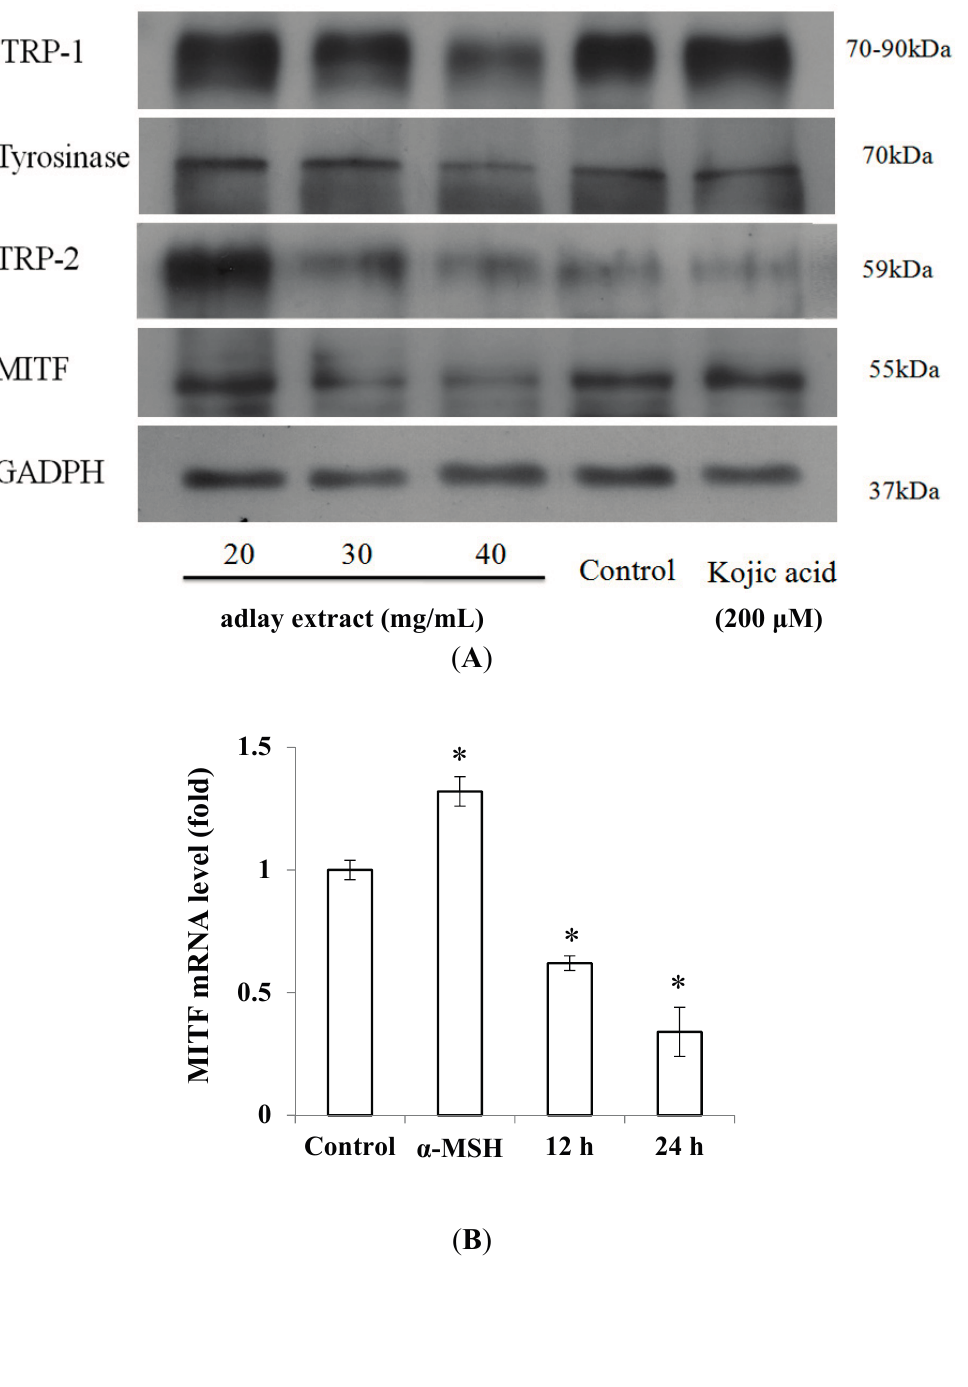
Figure 2. The effects of adlay extract on melanogenesis-related protein expression levels. ( A ) Western blotting of cellular proteins in B16F10 cells; ( B ) Total RNA from B16F10 cells treated with adlay extract (40 mg/mL) collected at the indicated time. microphthalmia-associated transcription factor (MITF) mRNA levels were examined by real time RT-PCR, using glyceraldehyde 3-phosphate dehydrogenase (GAPDH) as an internal control. (* p < 0.05 vs.